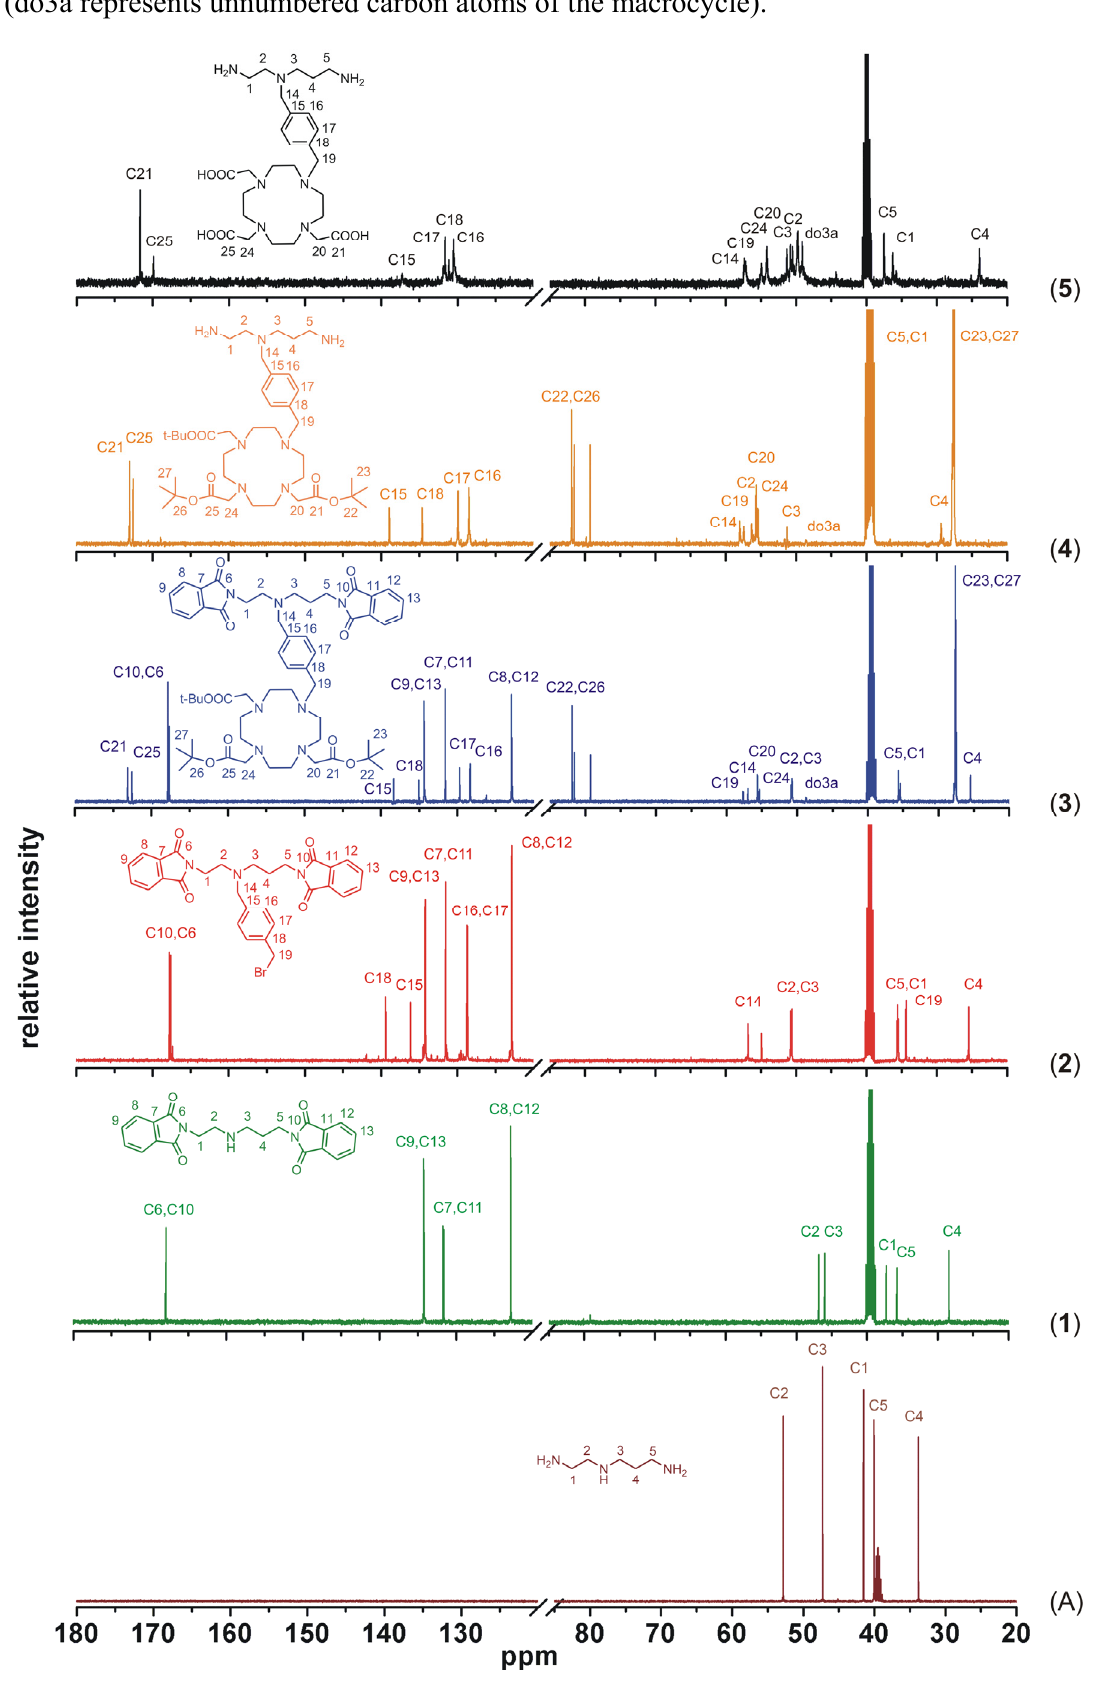
Figure 7. Comparison of 13 C-NMR spectra of the precursor N -(2-aminoethyl)propane-1,3- diamine ( A ), intermediates 1 – 4 and the final product 5 , together with signals assignment (do3a represents unnumbered carbon atoms of the